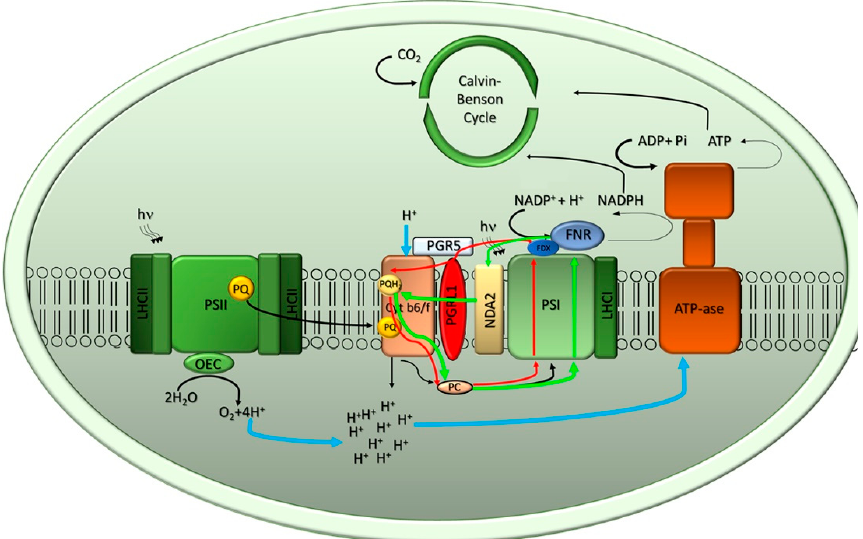
Figure 1. Schematic representation of photosynthetic electron transport. Arrangement of Photosystem I (PSI), Photosystem II (PSII), cytochrome b6f and adenosine triphosphate (ATP) synthase complexes within the thylakoid membranes is shown. The light-driven water splitting reaction leads to O 2 evolution and originates linear electron transport (LET), indicated with black arrows, from water to nicotinamide adenine dinucleotide phosphate (NADP + ), which is coupled to proton translocation from stroma into the luminal side of thylakoids during the light phase. The electrochemical gradient formed is used by the ATP synthase to produce ATP from Adenosine diphosphate (ADP) and Pi in the stroma. The NADPH and ATP formed during the light phase drive the Calvin–Benson–Bassham cycle reactions in the stroma. Two pathways of cyclic electron transport (CET) around PSI are indicated with red (Ferredoxin-dependent pathway) and green (NDA2-dependent pathway) arrows, respectively.